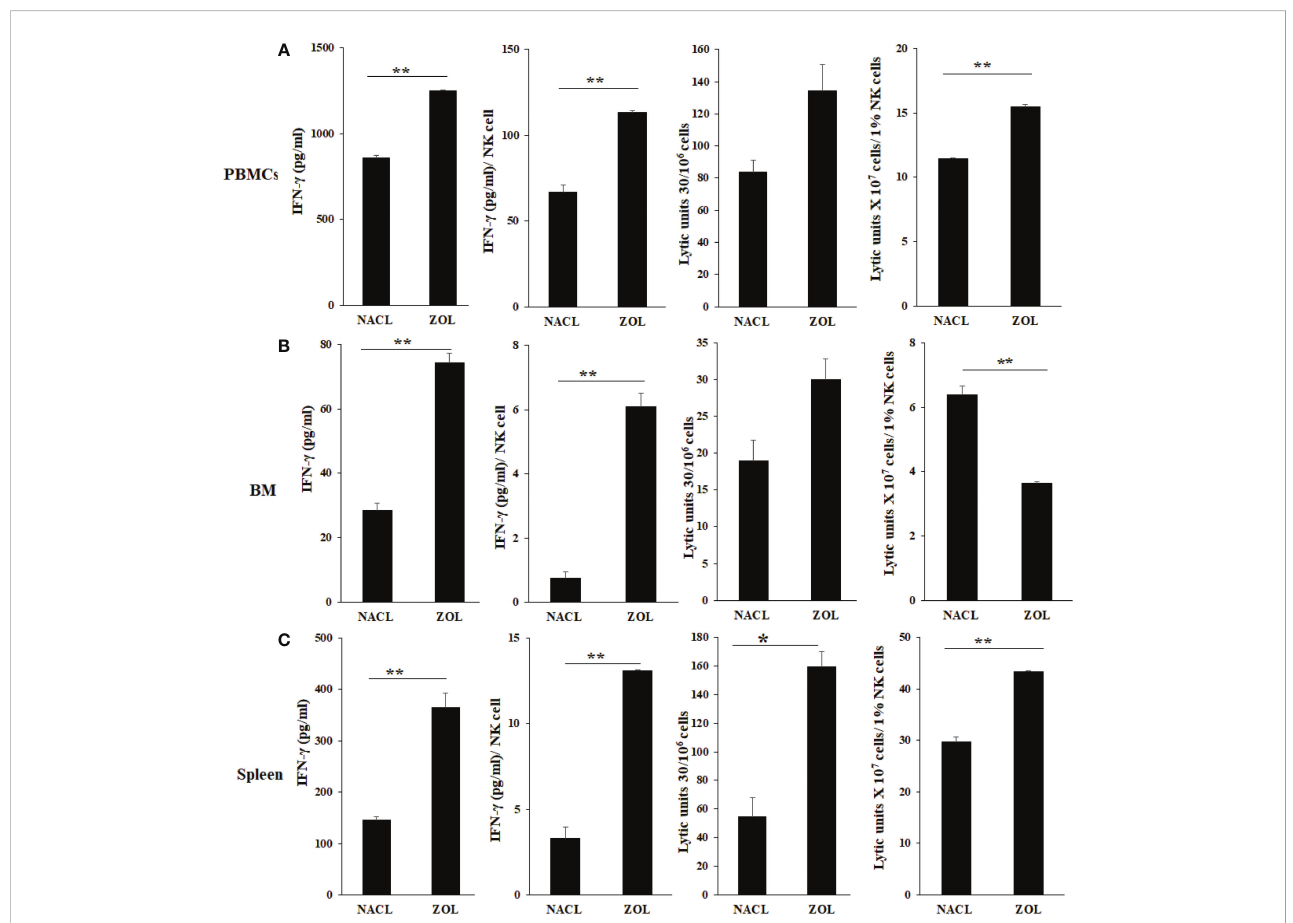
FIGURE 2 IFN- g secretion and NK-cell mediated cytotoxicity of PBMCs, BM, and splenocytes of NACL and ZOL-injected hu-BLT mice. Hu-BLT mice were administered with either 0.9% NACL or ZOL (500 µg/kg) via IV as described in Materials and Methods section. Four weeks after injections, mice were euthanized and tissues were harvested to obtain single cell suspension. PBMCs (A) , BM cells (B) , and splenocytes (C) of hu-BLT mice were cultured (2 × 10 6 cells/2ml) with IL-2 (1000 U/ml) for three days, after which the supernatants were harvested and the levels of IFN- g were determined using speci fi c ELISA. PBMCs (A) , BM cells (B) , and splenocytes (C) were used as effector cells in standard 4-hour 51 Cr release assay against human OSCSCs tumors. Lytic units (LU) 30/10 6 cells were determined using inverse number of effector cells required to lyse 30% of OSCSCs × 100. LUs per 1% NK cells were